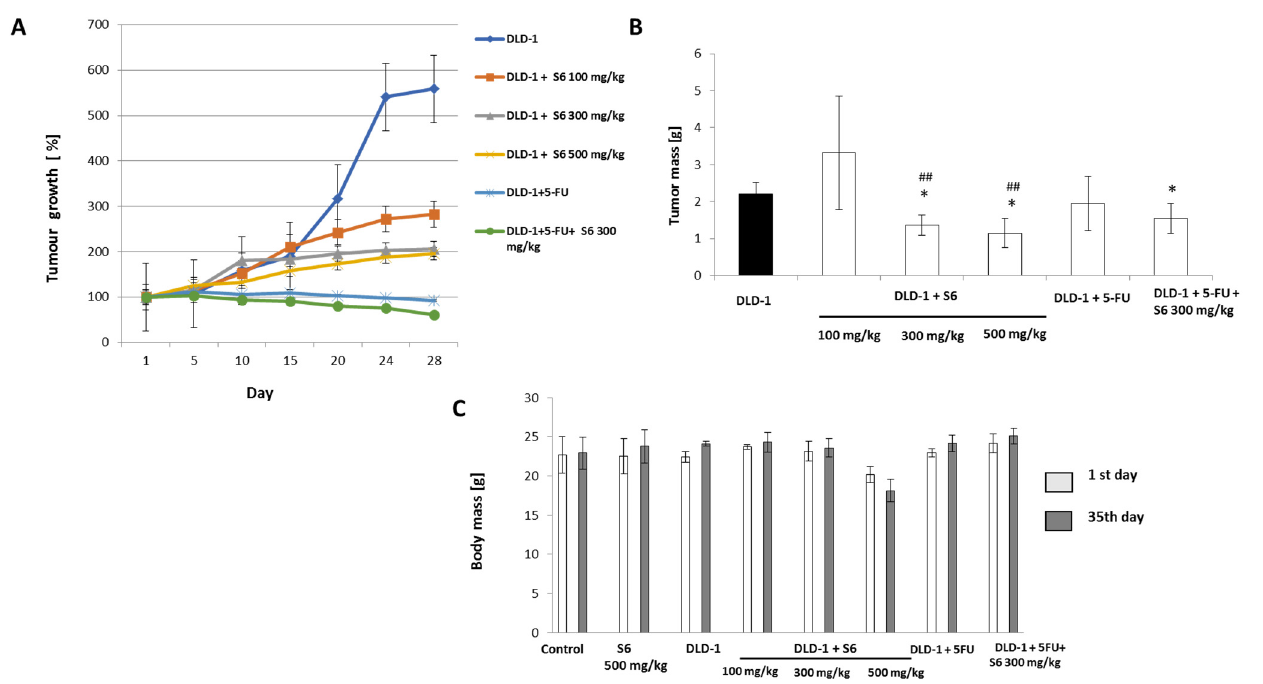
Figure 2. Tumor growth ( A ), tumor mass ( B ), and body mass ( C ) changes in studied groups. The results are expressed as the mean ± SEM for each group. * p < 0.05, compared with the DLD-1 group; ## p < 0.01 compared with the DLD-1 + S6 100 mg/kg.